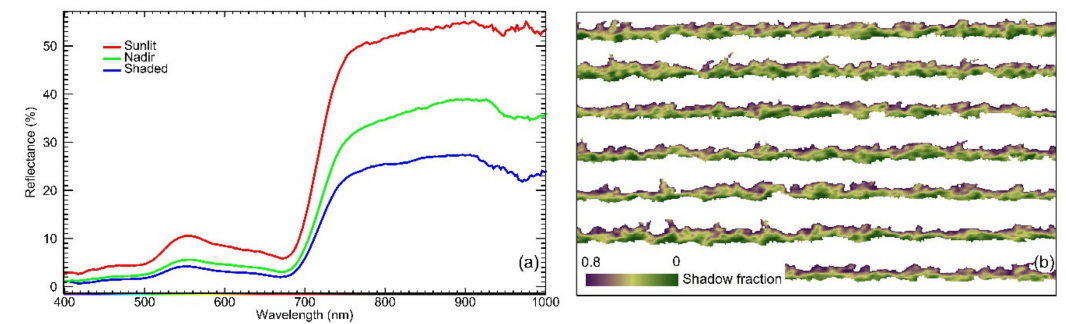
Figure 5. ( a ) Hyperspectral reflectance spectra of di ff erent canopy zones. ( b ) Canopy shadow fraction modeled with the Sequential Maximum Angle Convex Cone (SMACC) method.